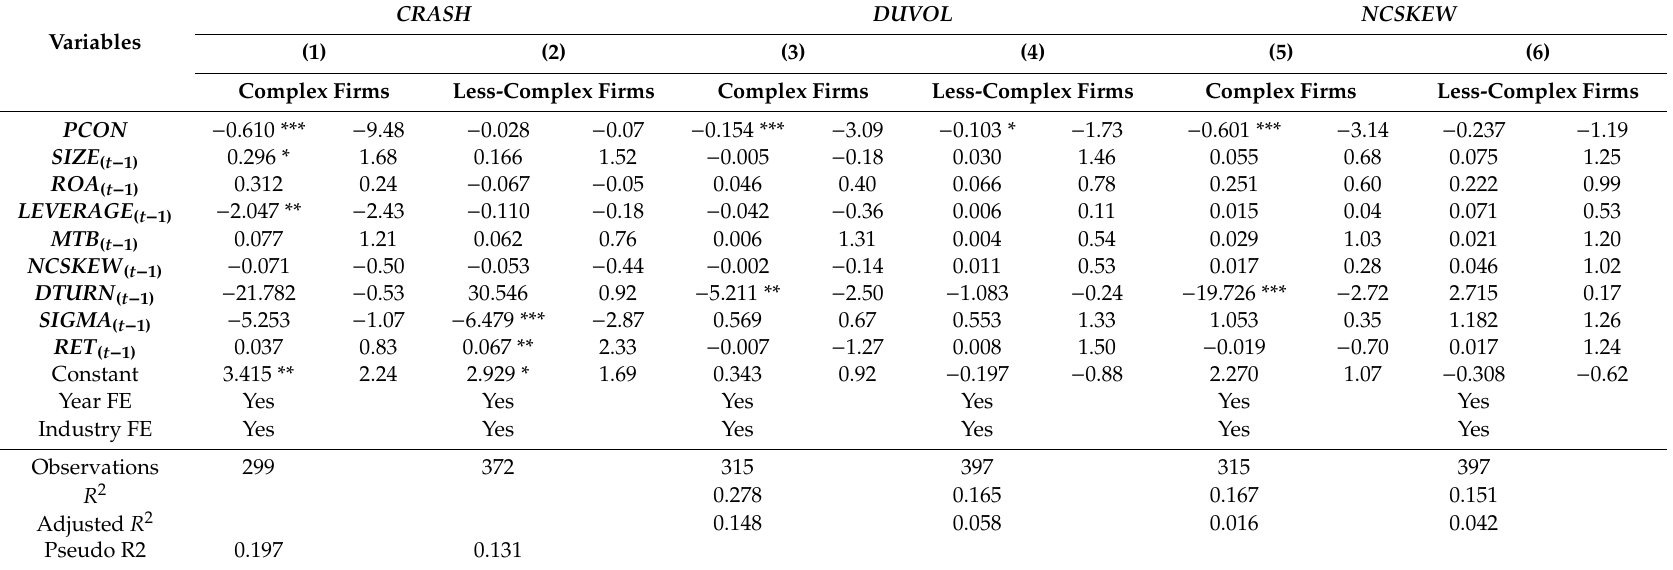
Table 9. Results of regression for complex and less-complex